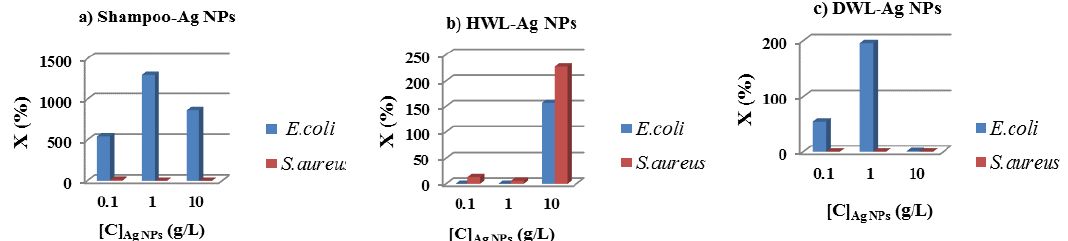
Fig.1. Percentage growth of bacteria vs. concentration of Ag NPs a) shampoo b) HWL and c) DWL